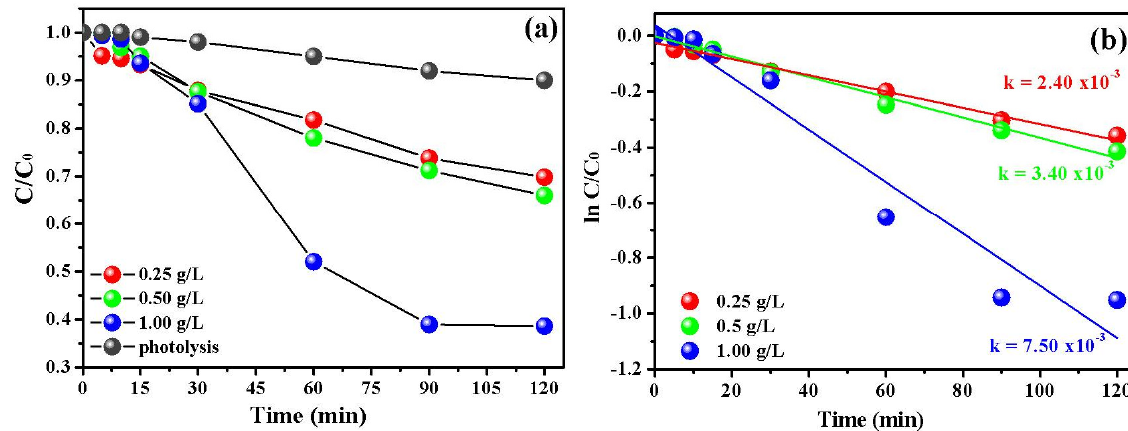
Figure 6. ( a ) Variation of MB absorption at different concentrations of photocatalyst and ( b ) pseudo first ‐ order kinetic withthe apparent rate constant.